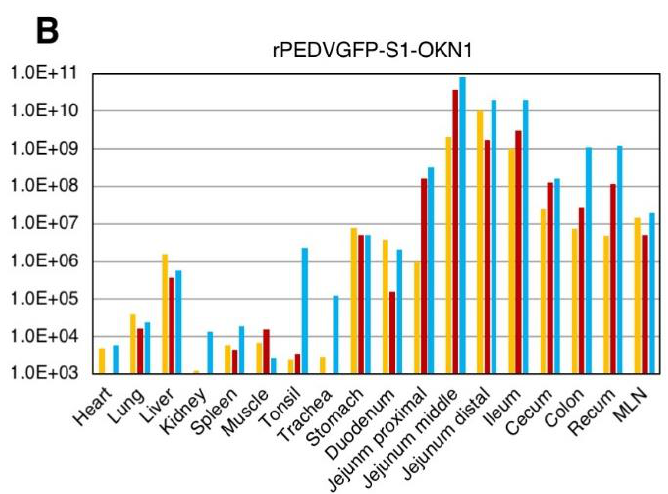
Figure 5. Virus distributions in various tissues collected from piglets inoculated with the-S chimeric strain, rPEDVGFP-S-OKN1 ( A ) and the S1-chimeric strain, rPEDVGFP-S1-OKN1 ( B ). Data are genome equivalents/mL in individual animals indicated in different colors as quantified at each time point by a real-time reverse-transcription quantitative PCR for the N gene.